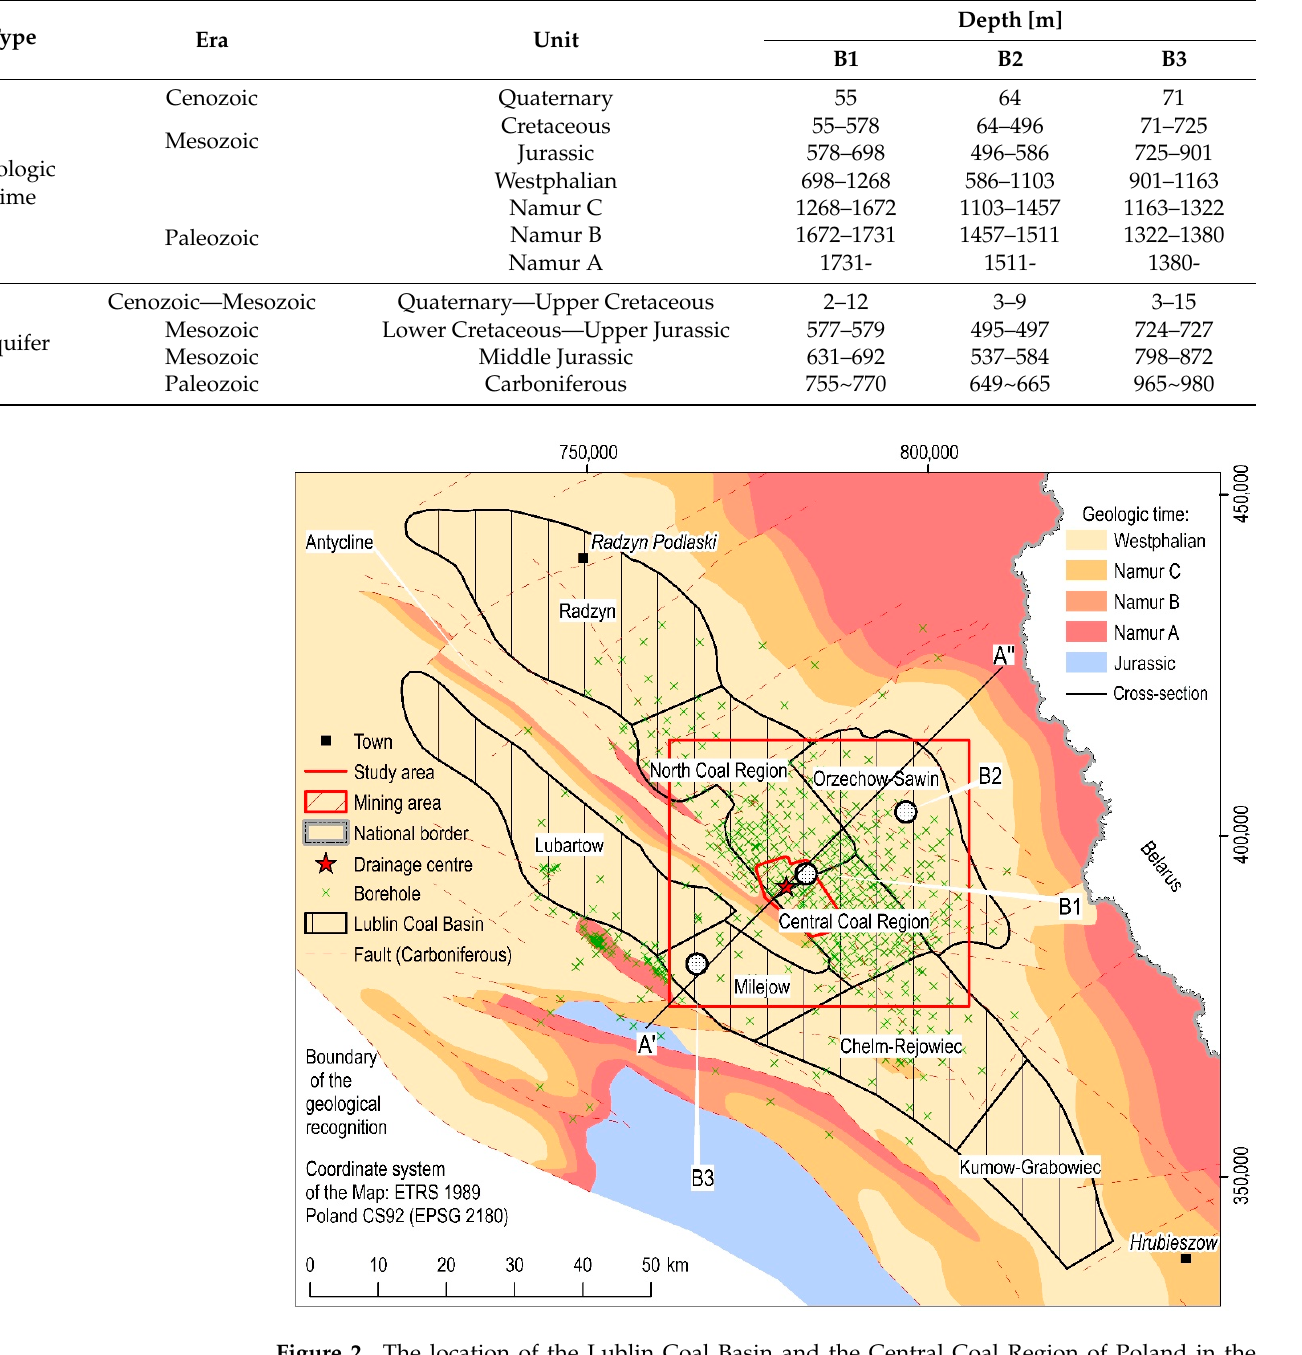
Figure 3. Schematic cross-section of geological strata and aquifer system in the area of interest, modi- fied after [67,146]. The location of the cross-section is depicted in Figure 2. Source of data: the Polish Geological Institute-National Research Institute.